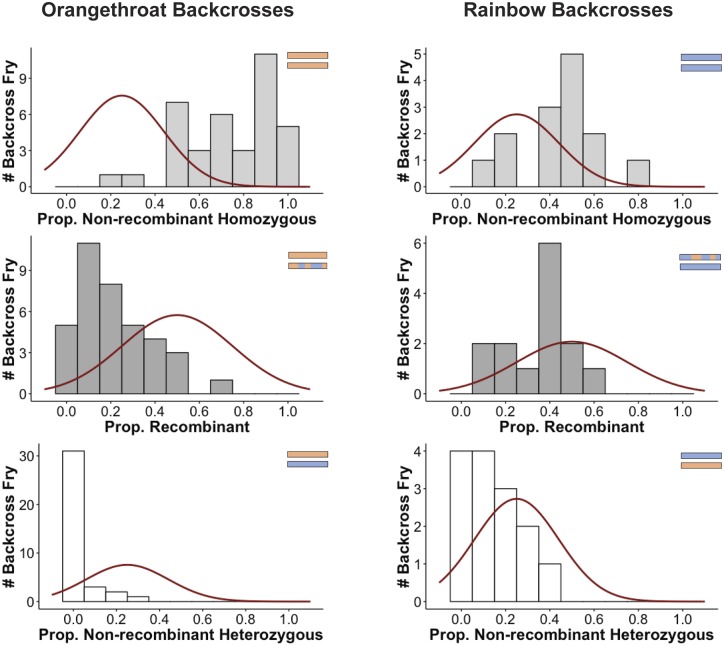
Distributions of the proportion of nonrecombinant homozygous, recombinant, and nonrecombinant heterozygous linkage groups (see fig. 1B) in backcrosses to orangethroat darters (left column; n = 36 fry) and in backcrosses to rainbow darters (right column; n = 13 fry). The expected distribution is overlaid in red.